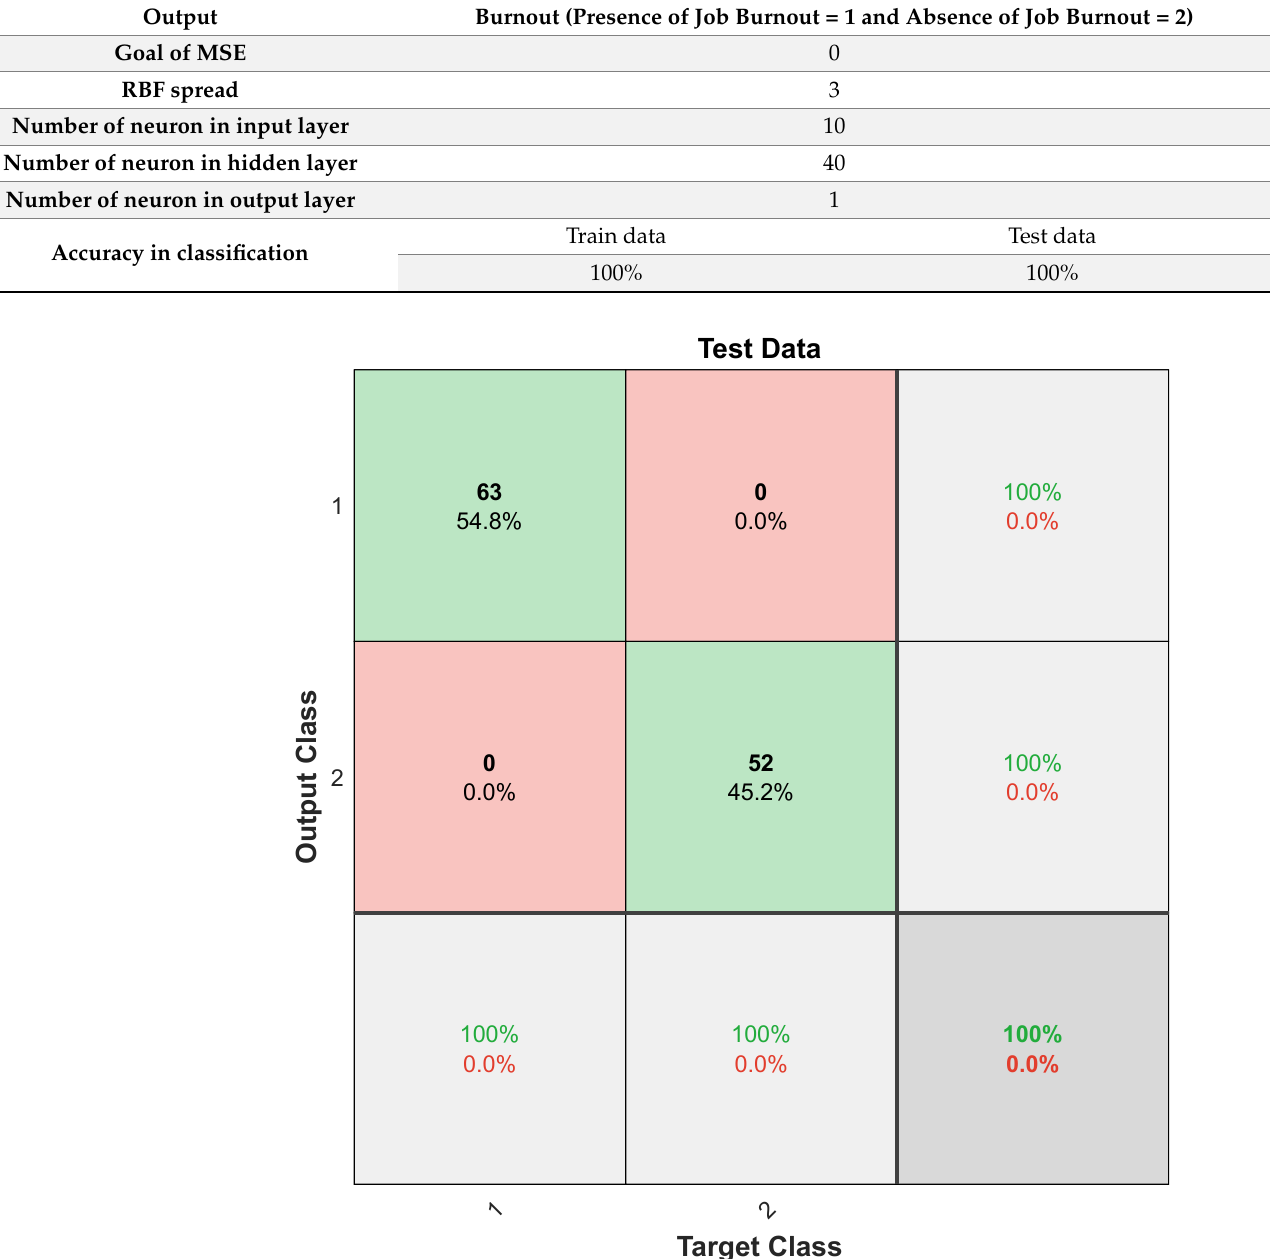
Figure 3. Confusion matrix for data.